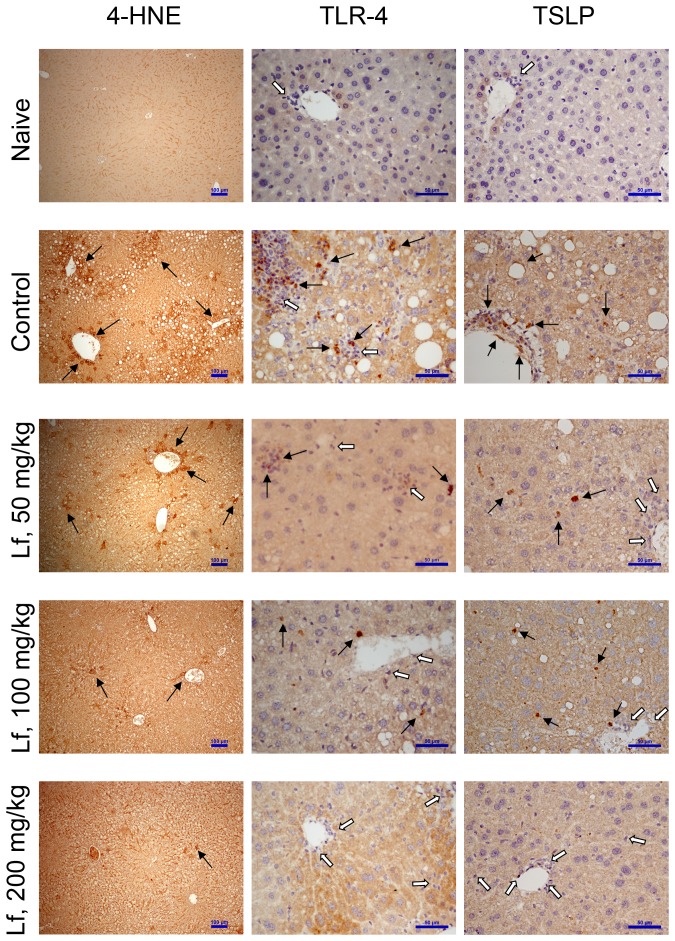
Treatment with lactoferrin improved the histology of livers of HFCS-induced HMMS mice.Immunohistochemical staining with 4-HNE, TLR-4, and TSLP show lipid peroxidation (4-HNE) and associated inflammatory markers (TLR-4 and TSLP). The control group showed lipid vascular accumulation and stained positive for 4-HNE, TLR-4, and TSLP, compared to the naïve group (indicated by arrows). Open arrows indicate negative staining for TLR-4 and TSLP, which indicate without infiltration of inflammatory cells. Treatment with lactoferrin at 50, 100, and 200 mg/kg markedly reduced 4-HNE, TLR-4, and TSLP expression. Scale bars represent 100 µm (4-HNE) and 50 µm (TLR-4 and TSLP).